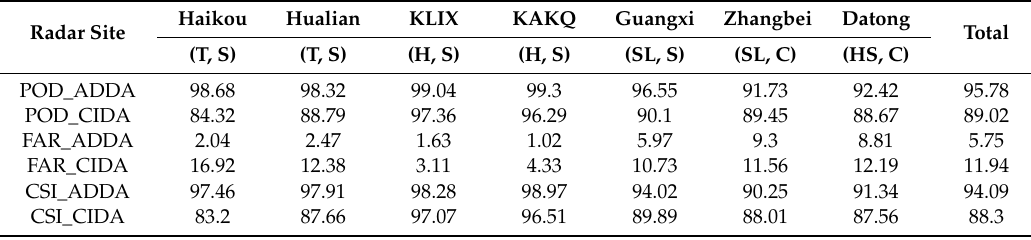
Table 2. List of dealiasing results (unit %) for all seven cases using automated dealiasing for